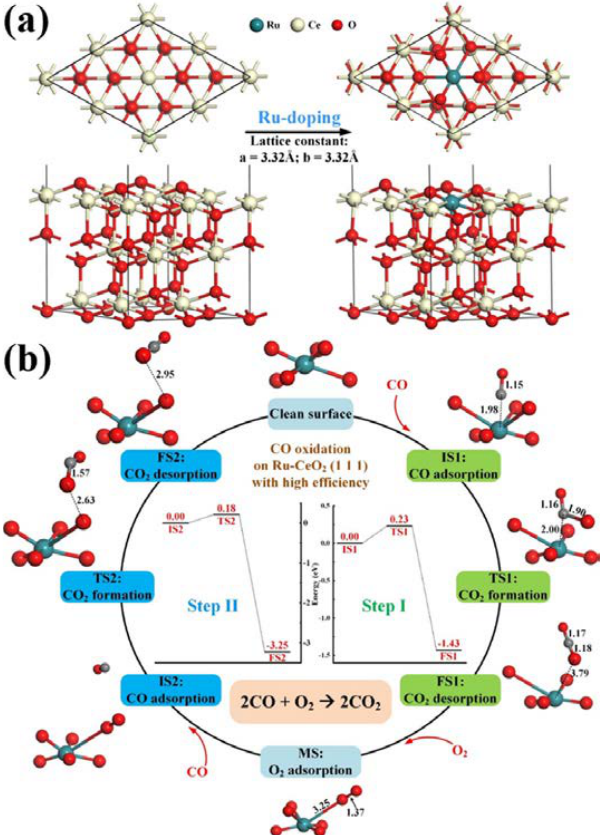
Figure 2. Mechanistic behavior of Ru-doped CeO 2 as an adsorptive electrocatalyst for CO oxidation, as reported by Liu et al. (2020) ( a ) Diagram showing the Ru-doping process and lattice formation of the catalytic structure. ( b ) Diagram showing the reaction steps for the catalyzed carbon monoxide